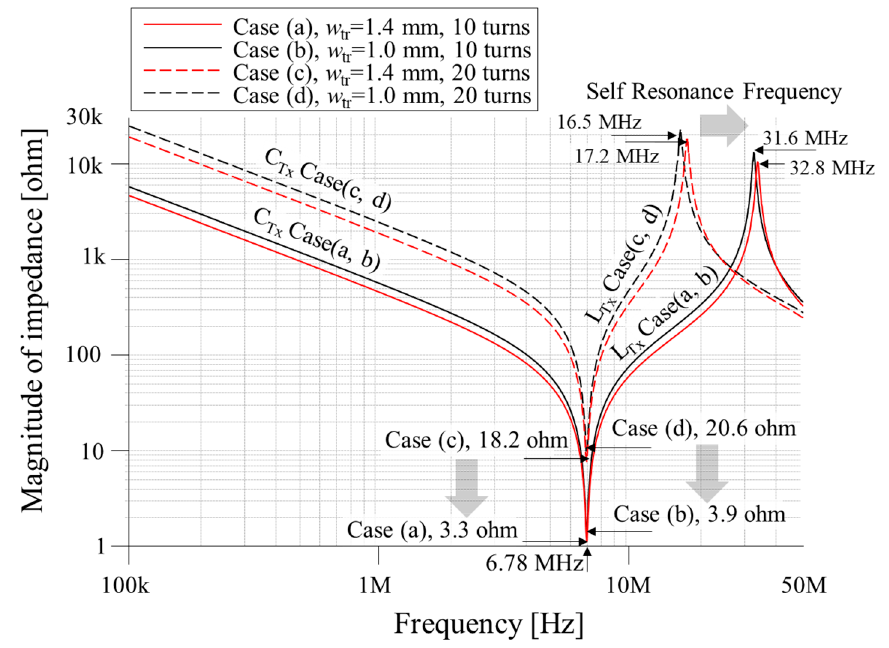
Figure 12. Measured magnitude of impedance for various coils. The ESR and effective resistance of coils are varied by the trace width and number of turns of coil.